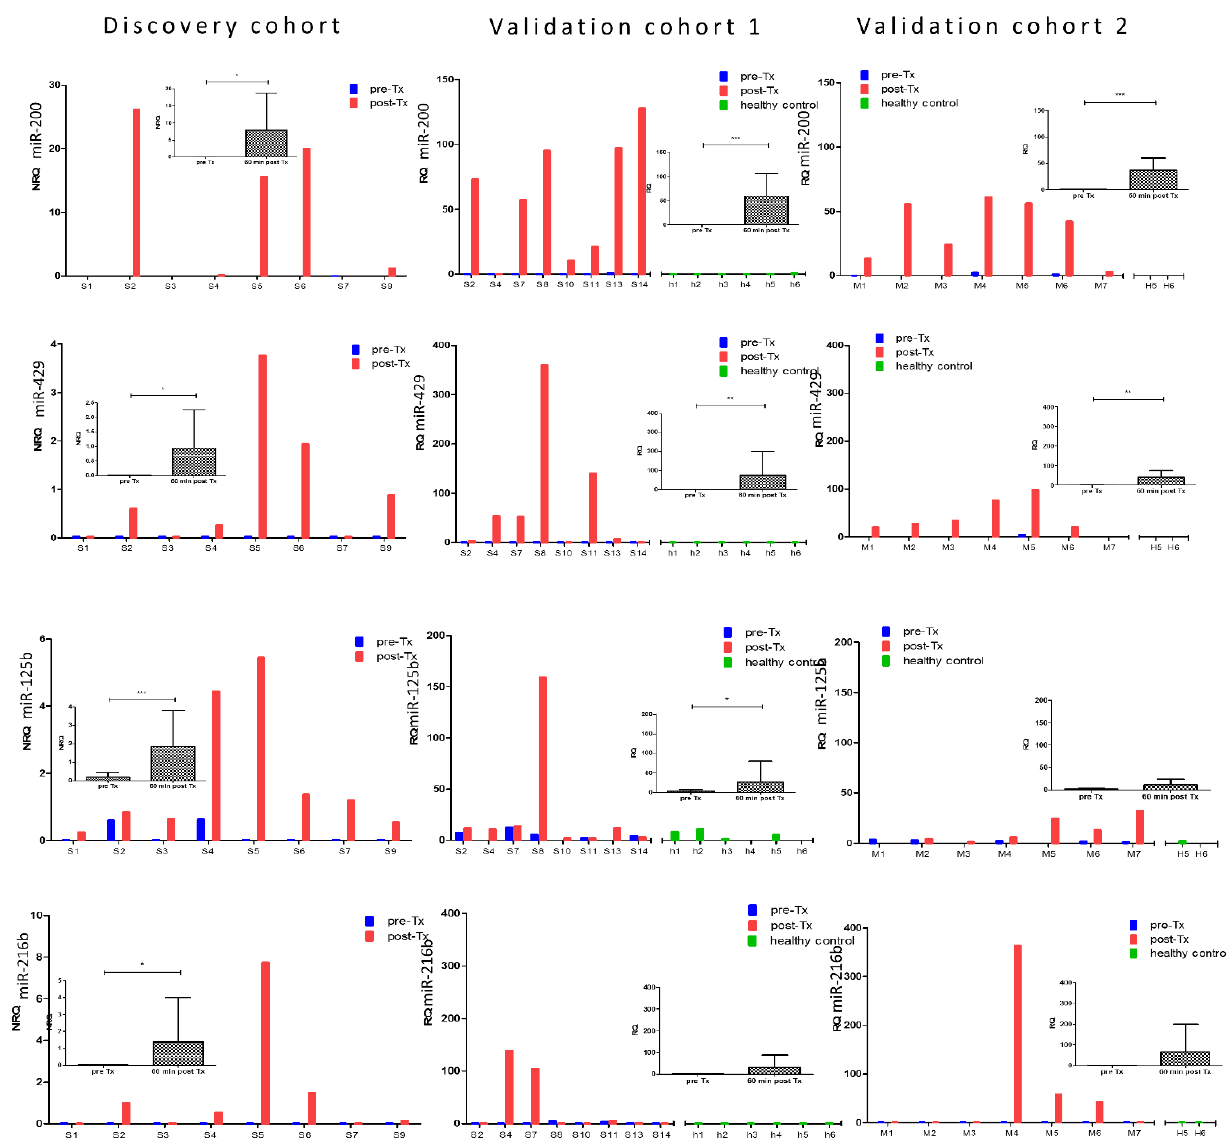
Figure 5. microRNA levels before and 1 h after islet transplantation in three independent cohorts of 4 microRNAs with lower islet endocrine enrichment. From top to bottom, panels show the NRQ microRNA levels in individual samples in the discovery cohort ( n = 8 transplants, Brussels) and RQ microRNA levels in the validation cohort 1 ( n = 8 transplants and n = 6 healthy controls h1-h6, Brussels) and validation cohort 2 ( n = 7 transplants and n = 2 healthy controls, H5-H6, Milan). Average ± SD and p -value (* p < 0.05; ** p < 0.005; *** p < 0.001, paired student t -test) in inset. Bar colors indicate pre-transplant (pre-Tx, blue), 1 h post-transplant (post-Tx, red) or healthy control (green).